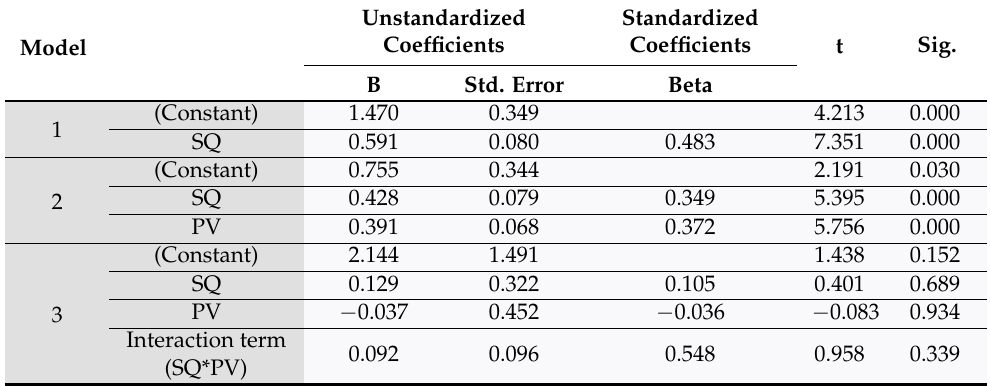
Table 7. Moderation